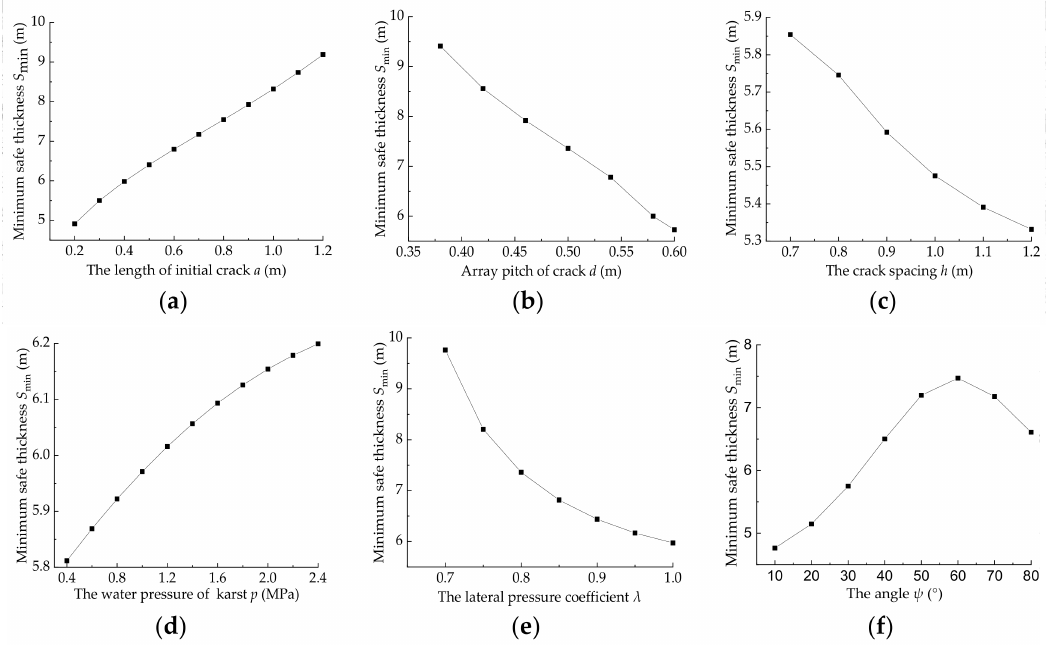
Figure 7. Relationship between minimum safe thickness of water-resistant strata and their influential factors. ( a ) Relationship between S min and a ; ( b ) Relationship between S min and d ; ( c ) Relationship between S min and h ; ( d ) Relationship between S min and p ; ( e ) Relationship between S min and λ ; ( f ) Relationship between S min and ψ